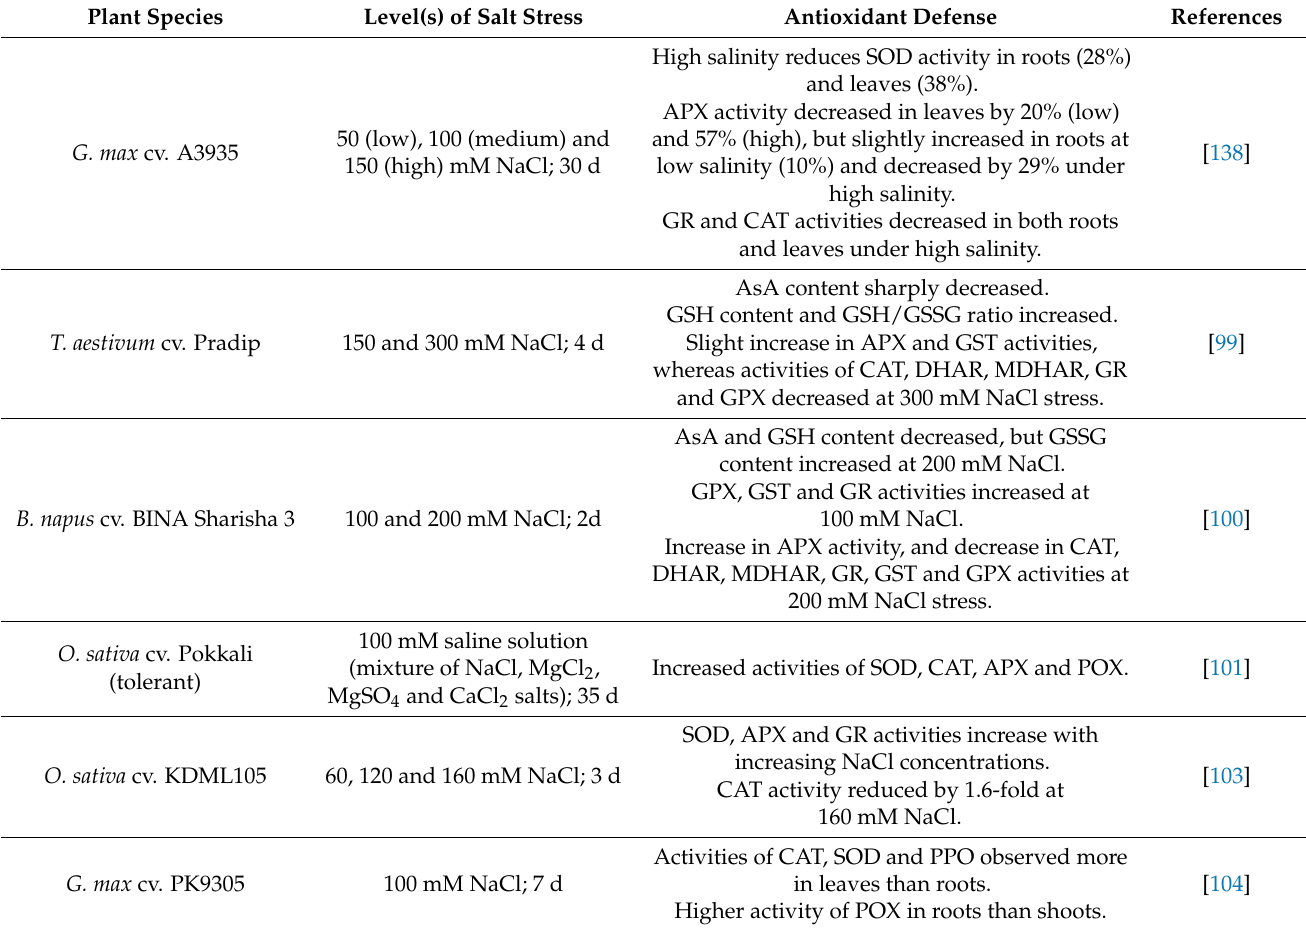
Table 2. Activities of antioxidant defense system against